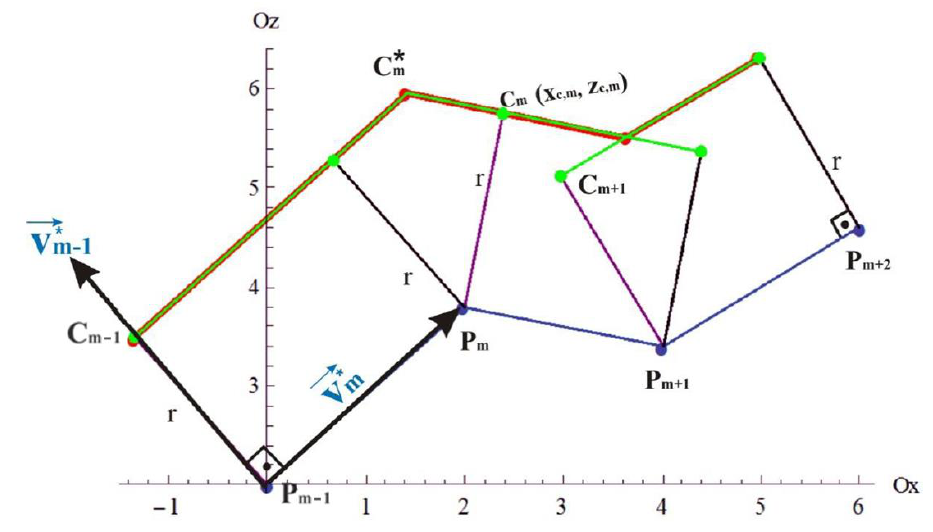
Figure 4. Representing the direct vectors.